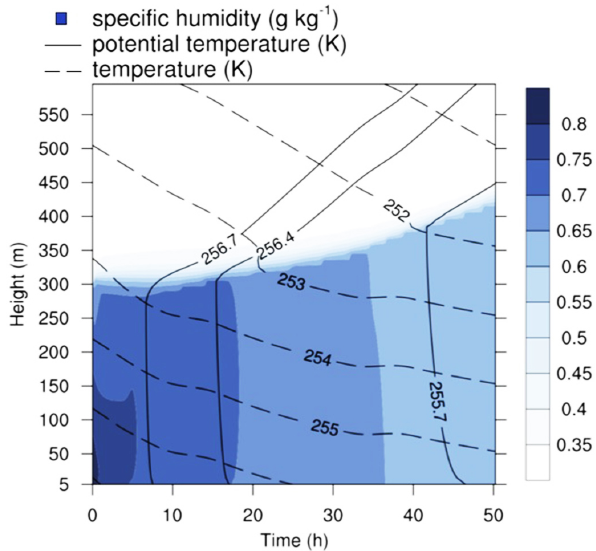
Figure 2. Modeled meteorological parameters include temperature (dashed contours), potential temperature (solid contours), and spe- cific humidity (blue). The boundary layer height is initialized to be